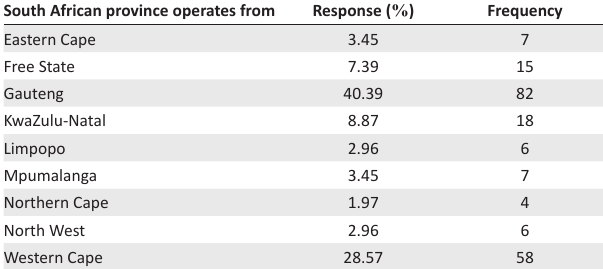
TABLE 2: Percentage response and frequency of provinces ( N = 203).